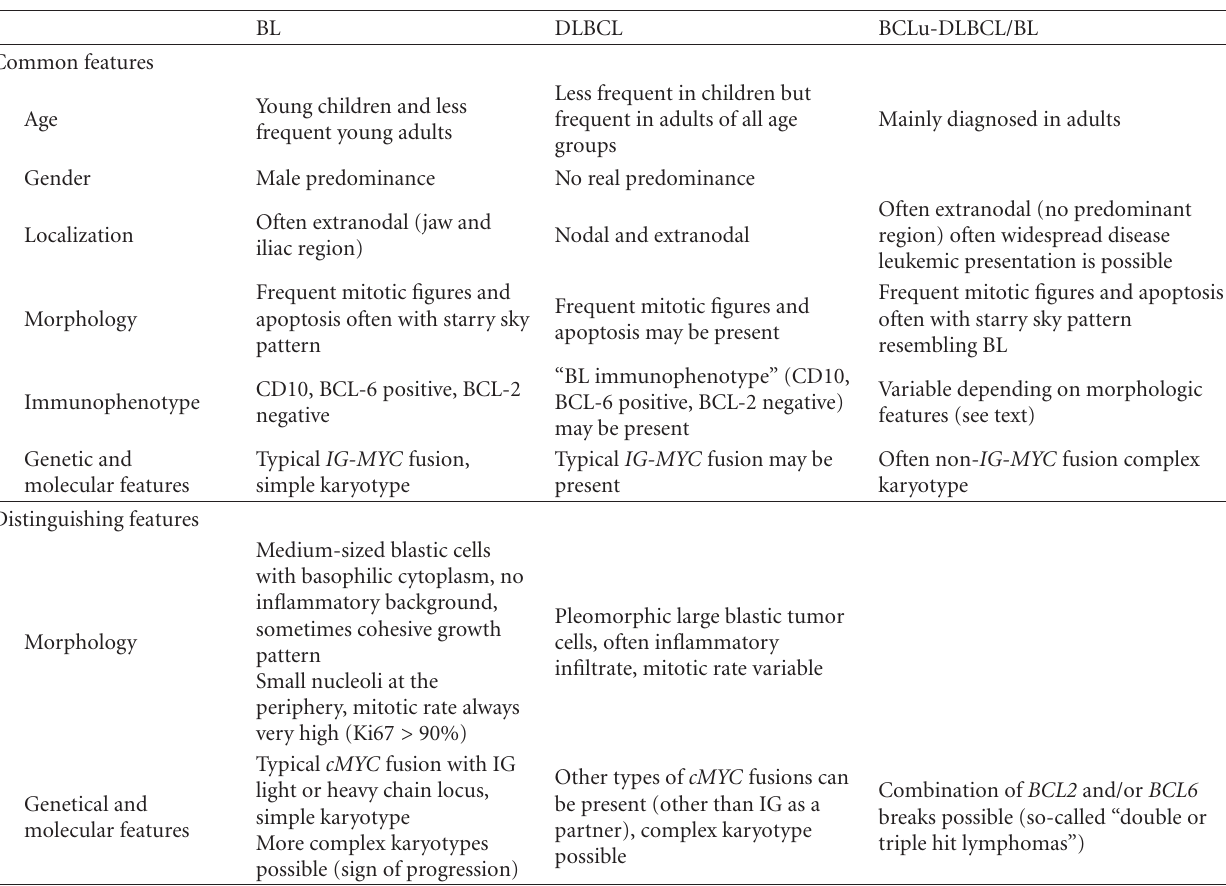
Table 2: Common and distinguishing features of BL, DLBCL, and B-cell lymphoma, unclassifiable, with features intermediate between DLBCL and BL